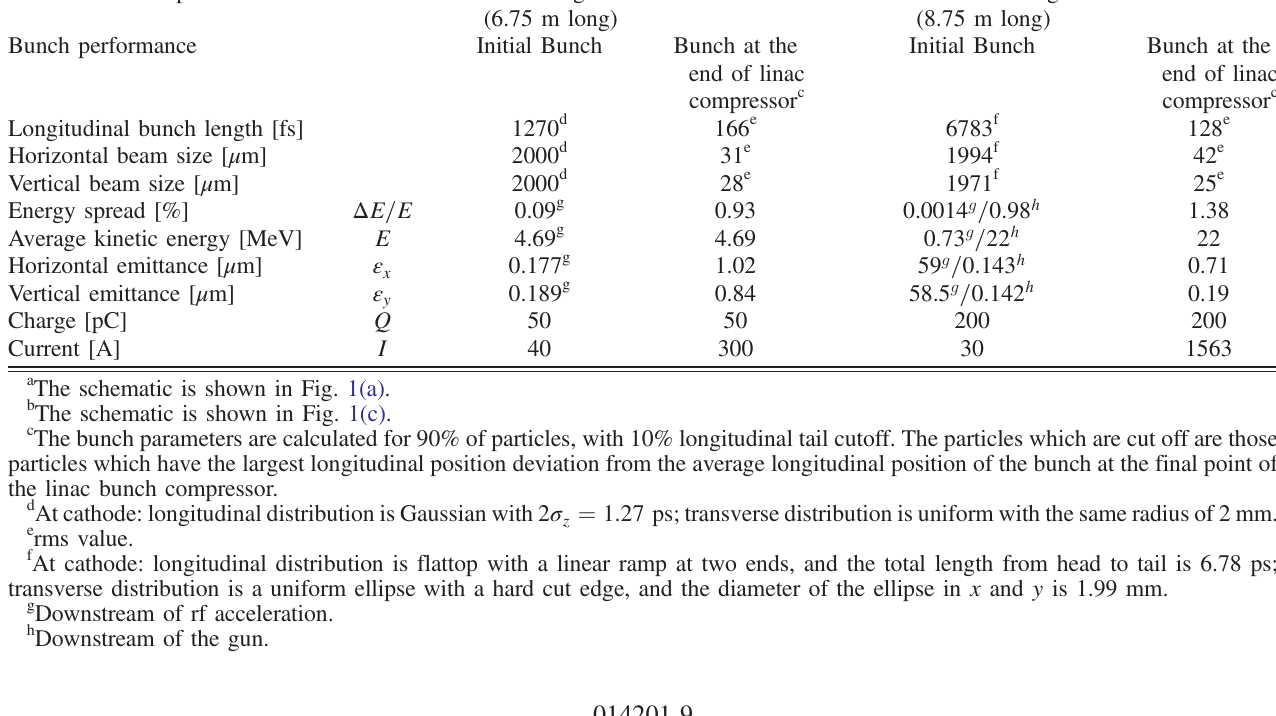
TABLE I. Performances of the BNL rf gun linac compressor and the LBNL ’ s VHF gun linac compressor. Linac bunch